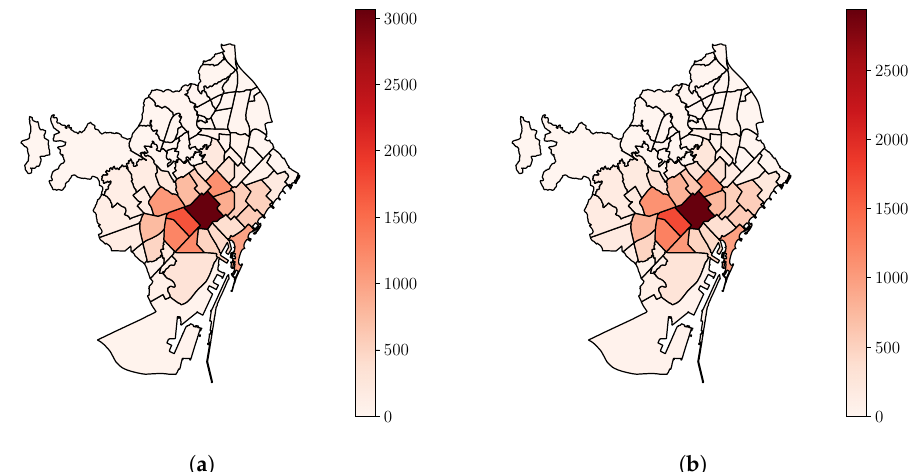
Figure 5. Neighborhood distribution maps of the whole data set: ( a ) Starting point per neighborhood; ( b ) Finishing points per neighborhood.